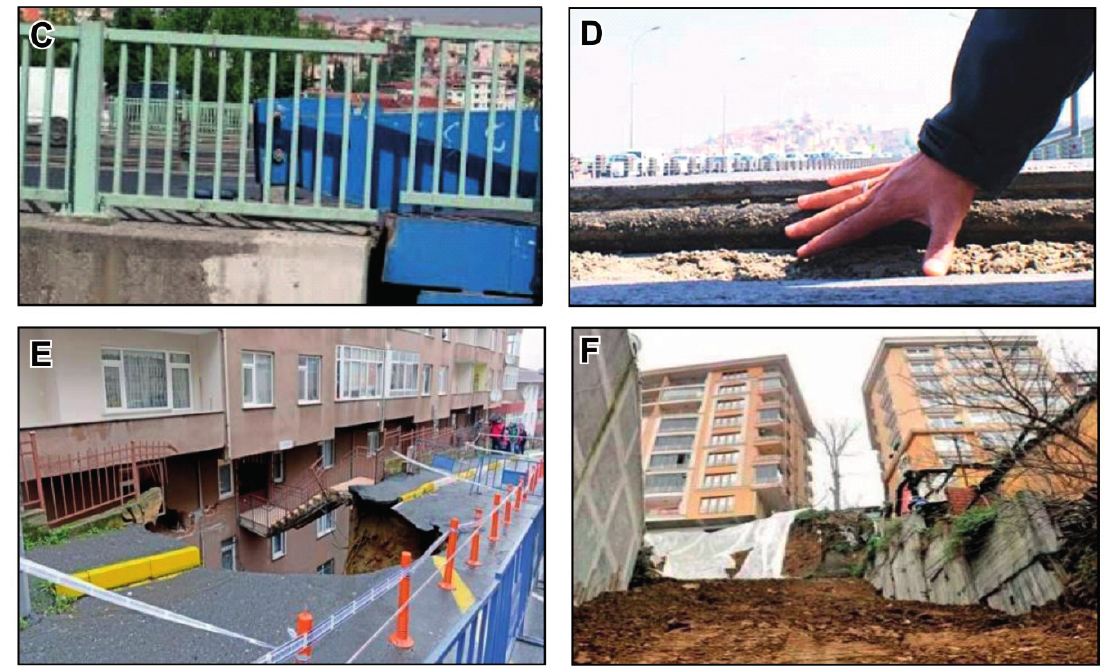
Figure 7. ( A ) Optical satellite image of the Golden Horn and near vicinity. ( B ) Zoomed view of the low resolution SBAS-DInSAR map, related to the northern neighborhoods along the Golden Horn, including Ayvansaray (UNESCO World Heritage Site). ( C , D ) Damage observed at the Golden Horn Bridge: displacement affecting a joint of the bridge (C) and the road of south-western part of the bridge (D). ( E , F ) Ground collapse along the road side at the Silahtaraga Street, Eyup. For location of damaged sites see Figure 7A. Photographs retrieved from Milliyet and Hurriyet Gazetesi